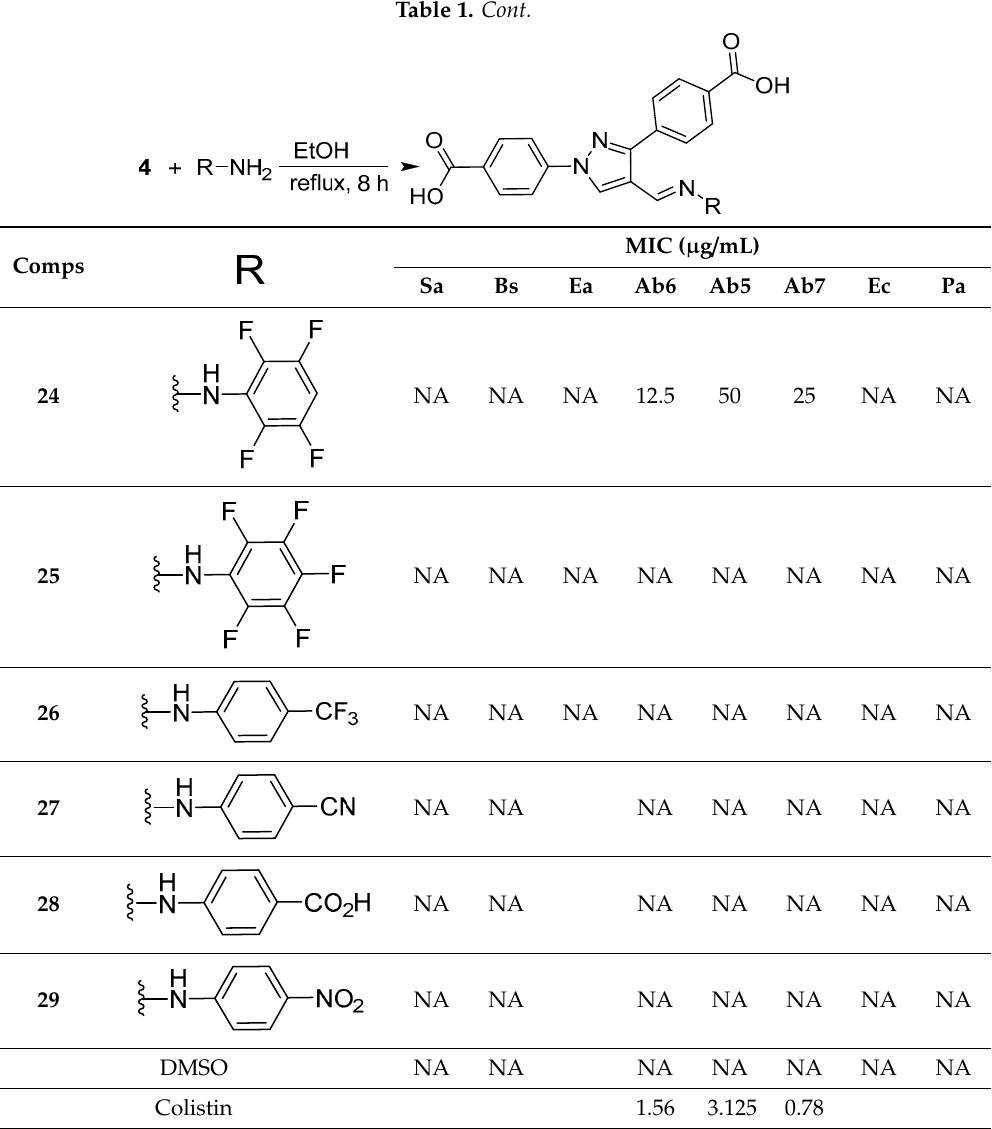
Table 1. Synthesis and antimicrobial activity of (pyrazole-1,3-diyl)dibenzoic acid substituted hydrazone derivatives.